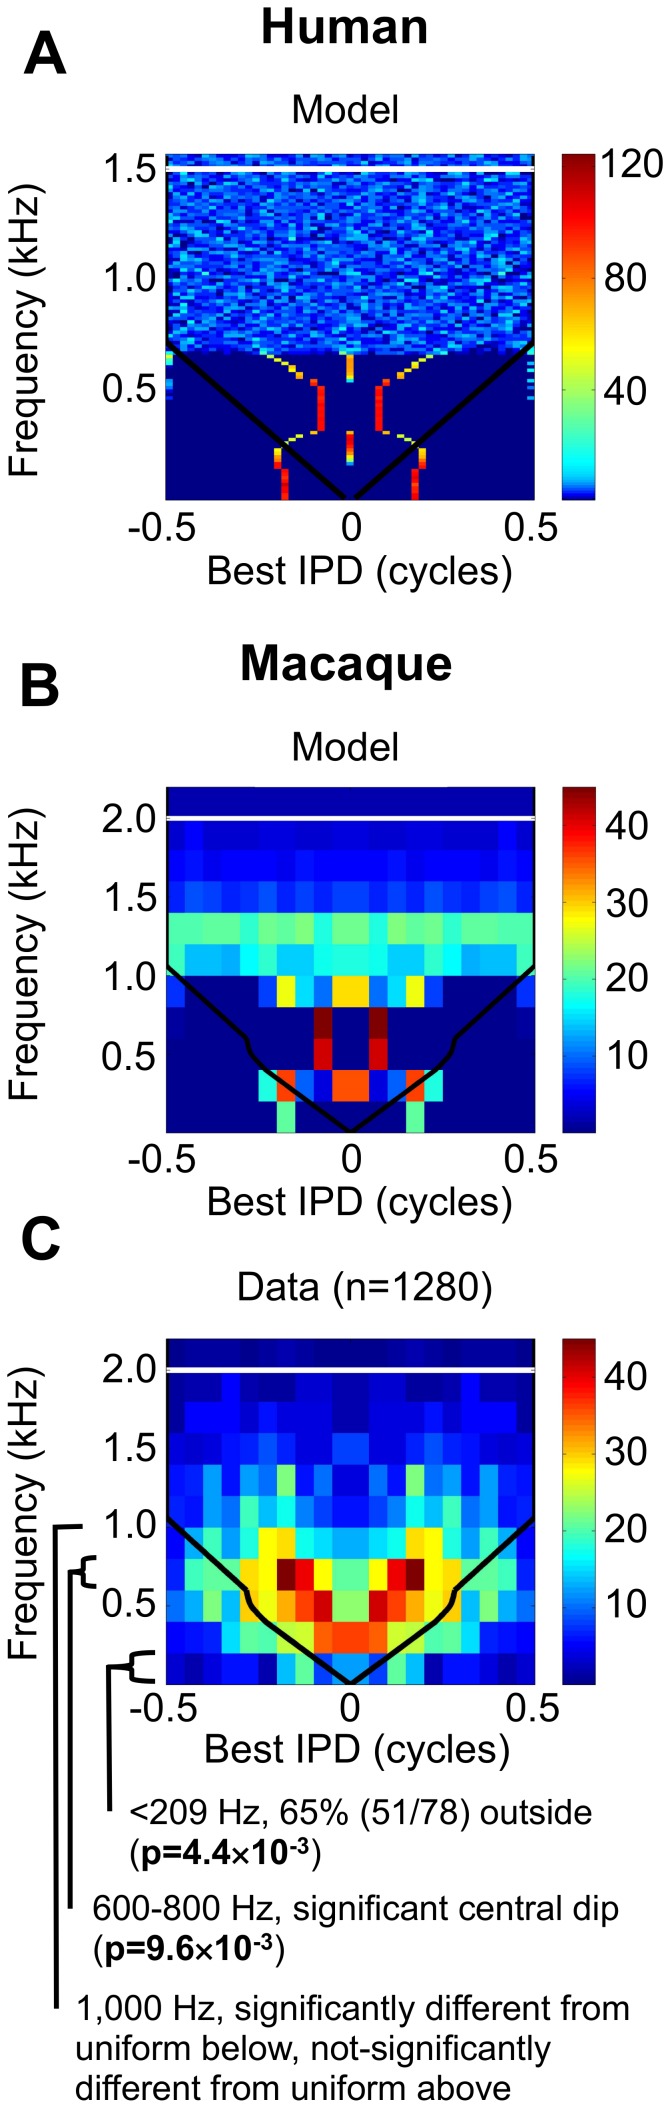
Best delay distributions for large primates.(A) The predicted distributions of best IPDs by the optimal-coding model for the human (max. ITD, ∼690 µs, highest frequency with ITD-sensitivity ∼1500 Hz). Color, number of best IPDs in an IPD bin for a given frequency band (200 best IPDs per band modelled), bin sizes as Figure 1D, otherwise format as Figure 2A. (B) The predicted distributions of best IPDs by the optimal-coding model for the macaque (max. ITD, 470–575 µs, max. ITD-sensitive frequency ∼2000 Hz). Format as Figure 2A. (C) Distribution of 1280 best IPDs, recorded from macaque auditory cortex, mirrored and then plotted as a 2D histogram using 200-Hz frequency bins and 0.05 cycle IPD bins. Format as Figure 2A.